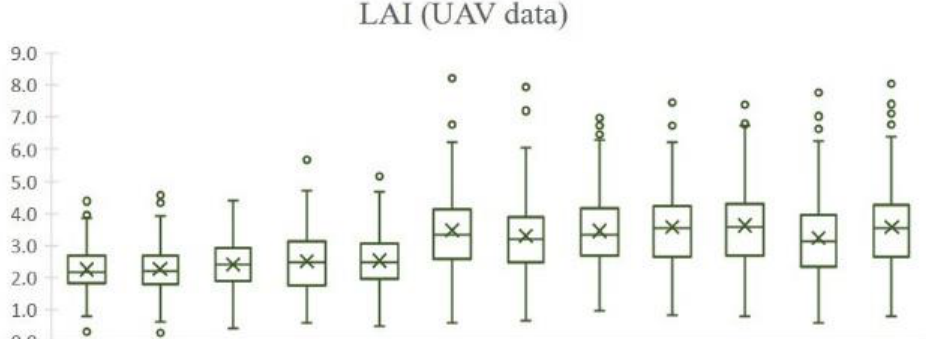
Figure 5. Behaviour of the LAI estimated with the UAV.